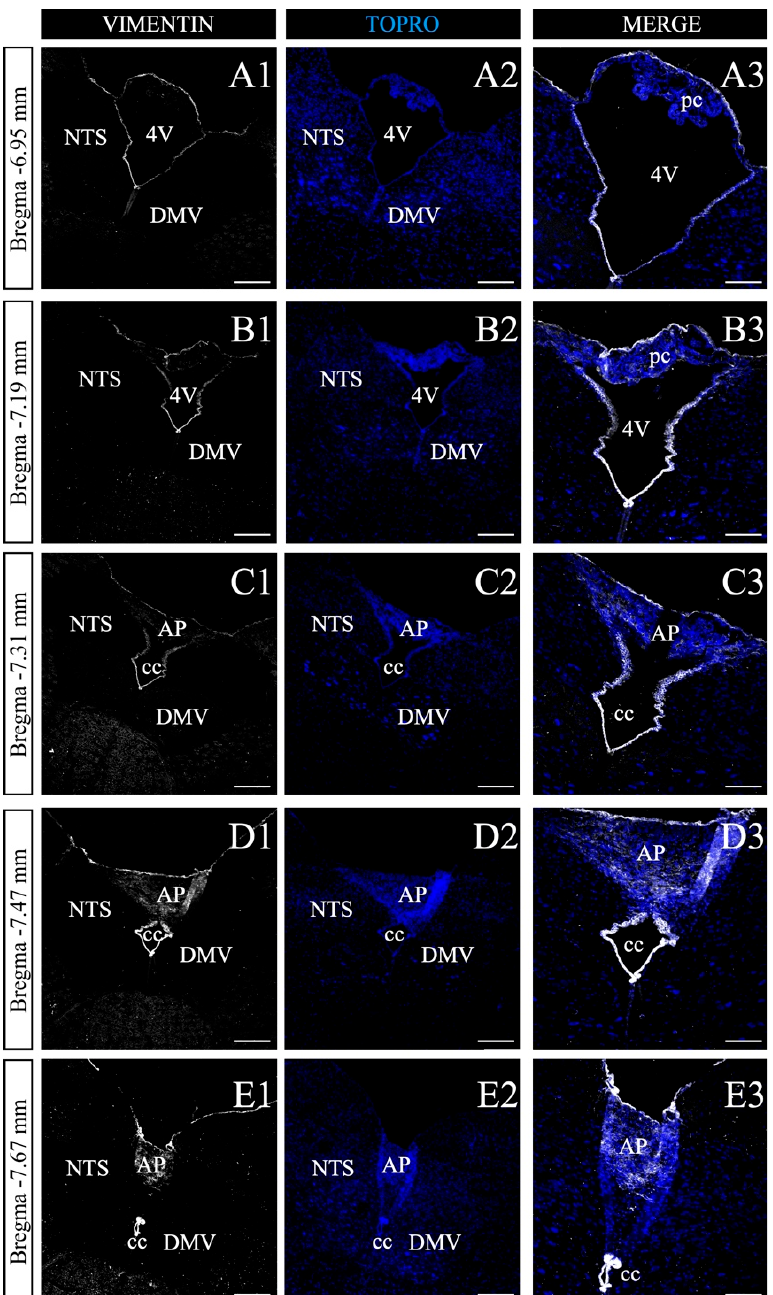
Figure 4. Antero-posterior screening of vimentin+ cells in the dorsal vagal complex. ( A1 – E3 ). Repre- sentative coronal sections of the mice posterior midbrain, between bregma − 6.95 and − 7.67 mm. Sections were processed with anti-vimentin (white), and TOPRO-3 nuclear marker (blue). Vimentin staining along the anteroposterior axis label the choroid plexuses (pc; ( A1 – B3 )), the area postrema (AP; ( C1 – E3 )), as well as the fourth ventricle (4V; ( A1 – B3 )) to form the central canal (cc; ( C1 – E3 )). Vimentin+ cells in the AP labels vagliocytes. Augmented images are shown in column 3, respectively. NST, the nucleus of the solitary tract. DMV, the dorsomedial nucleus of the vagus. Scale bar of columns 1, 2 and 3: 200 and 120 µ m,